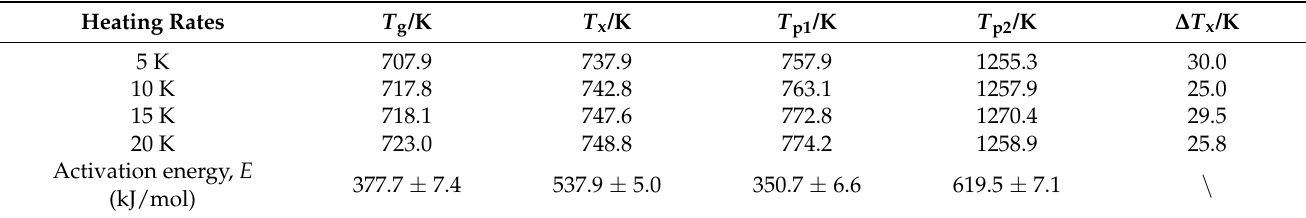
Table 3. The characteristic temperatures obtained by DSC traces for (Cu 43 Zr 47 Al 7 Ag 3 ) 99.5 Co 0.5 amorphous powders and the corresponding activation energies.